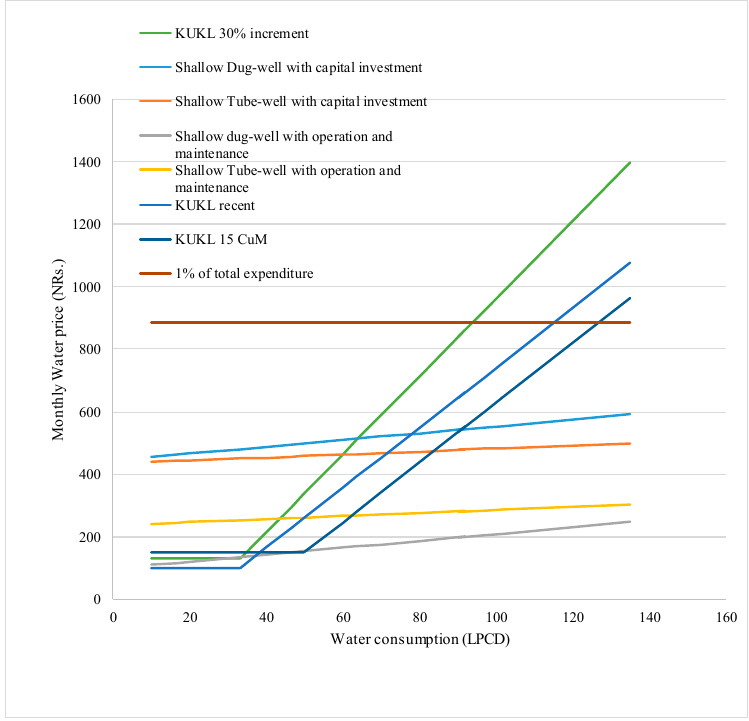
Figure 3. Monthly water price of various sources per building depending on water consumption.